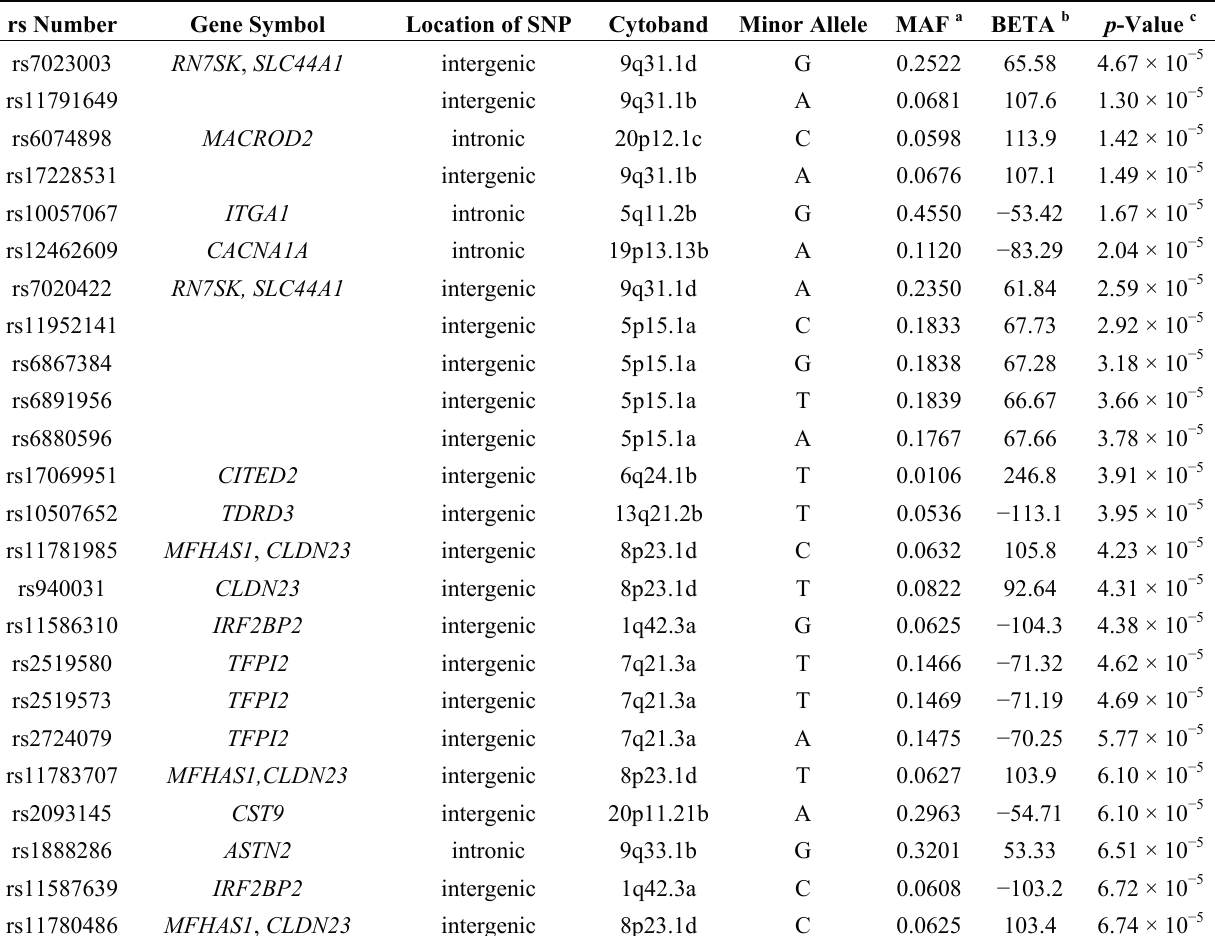
Table 1. Single nucleotide polymorphisms (SNPs) associated with physical activity by single-SNP association tests ( p -value < 10 − 4